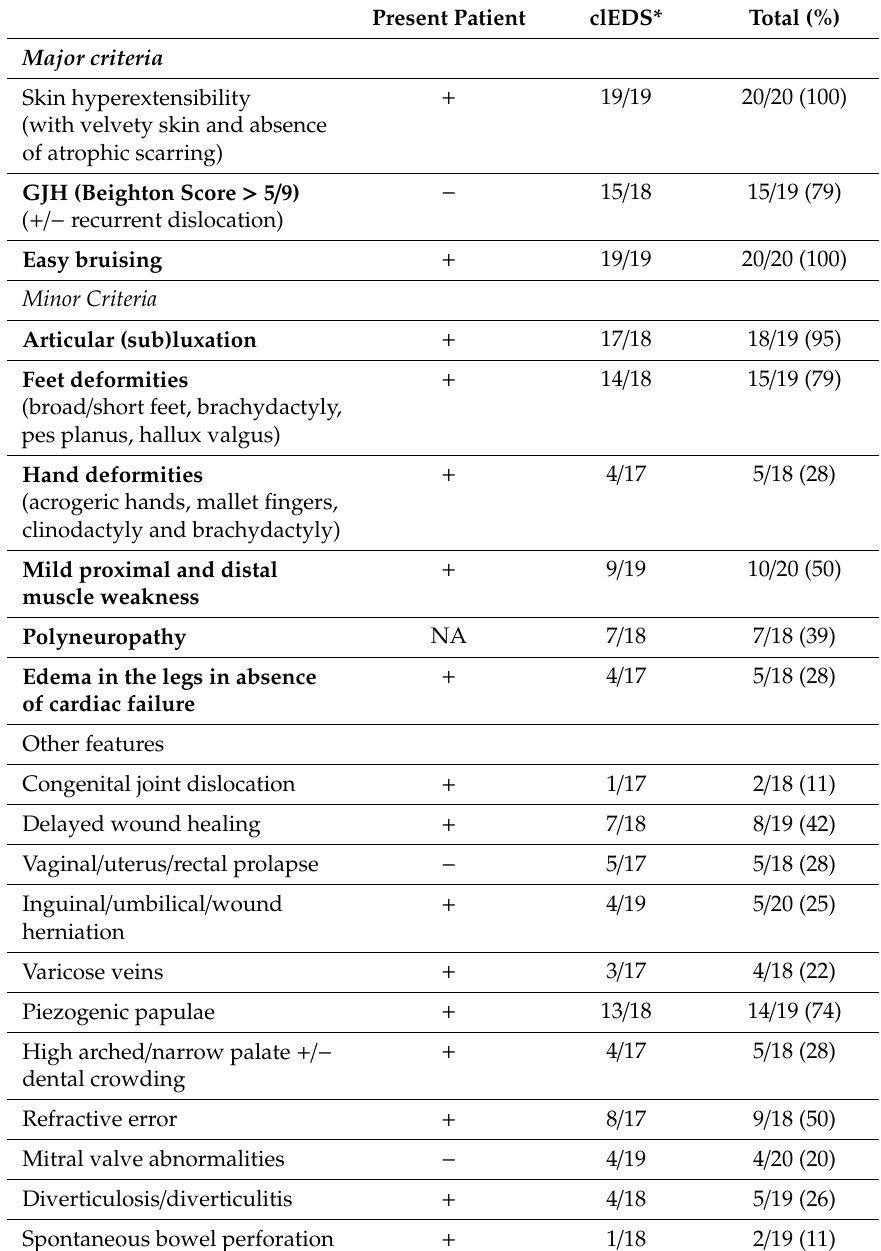
Table 1. Summary of clinical features of patients with biallelic TNXB